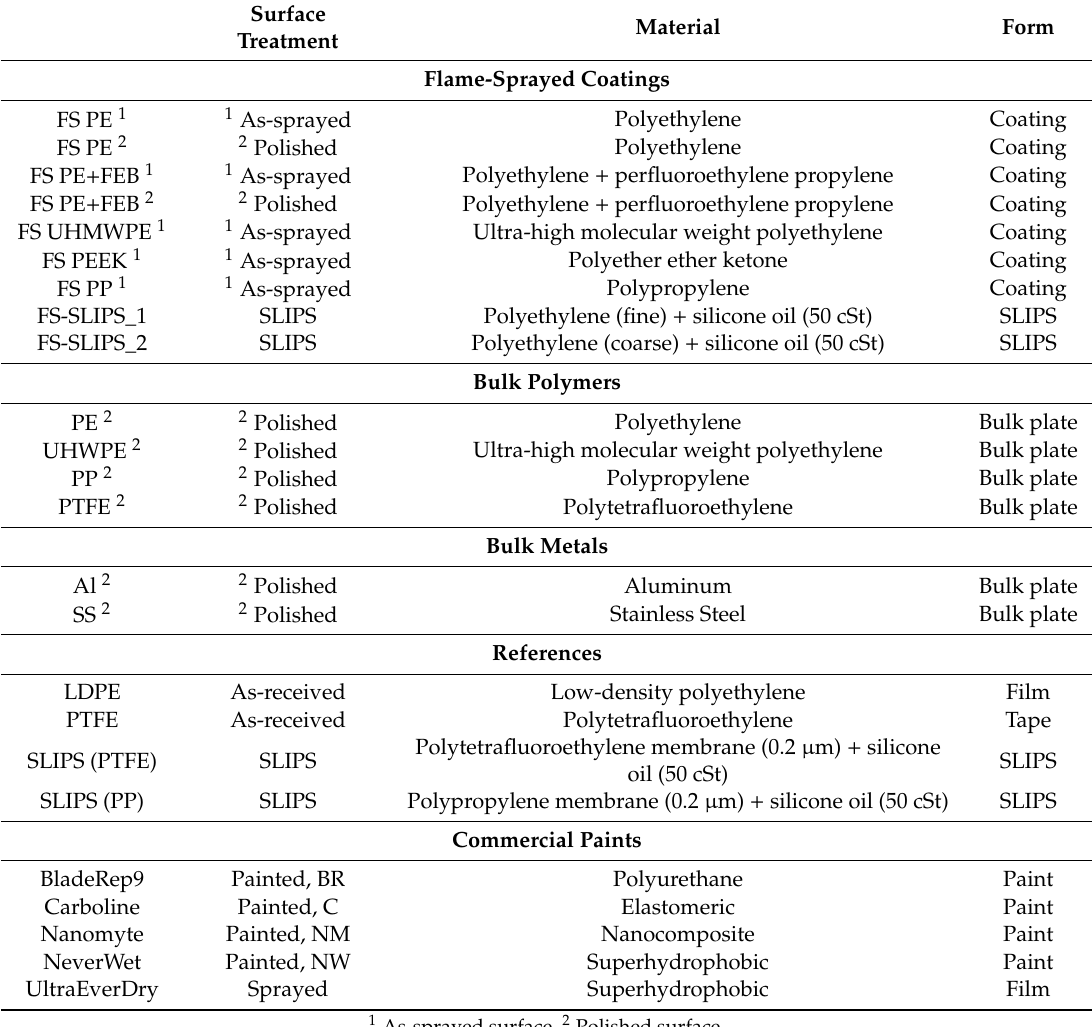
Table 1. Coatings and surfaces used in this study divided into di ff erent material